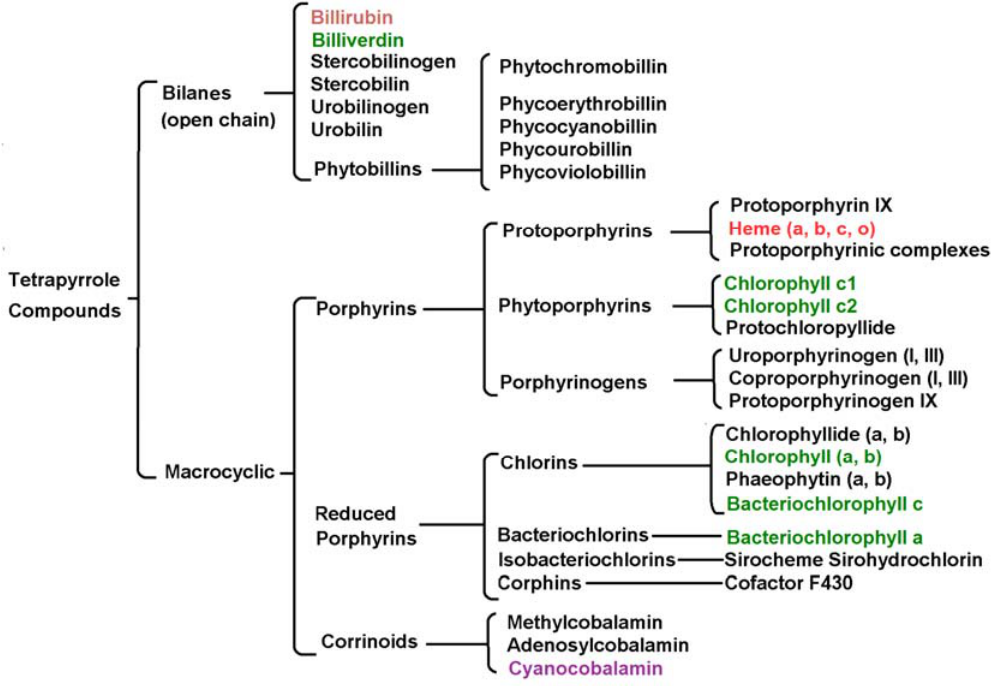
Figure 2. Natural tetrapyrrole compounds can be classified as open chains or bilanes and macrocyclic tetrapyrrolic